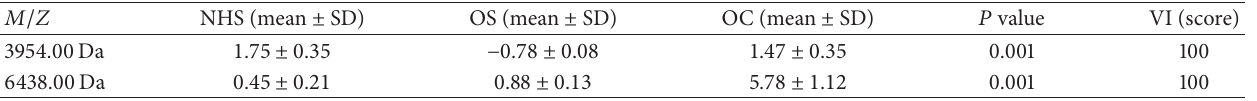
Figure 1: The SELDI-TOF-MS profiles of osteochondroma (OC), osteosarcoma (OS), and normal human serum (NHS) at the 6438 Da. The SELDI-TOF-MS profiles of the serum samples from OC (a), OS (b), and NHS (c). Table 1: The 𝑀/𝑍 s of 2 special serum proteins in three groups.